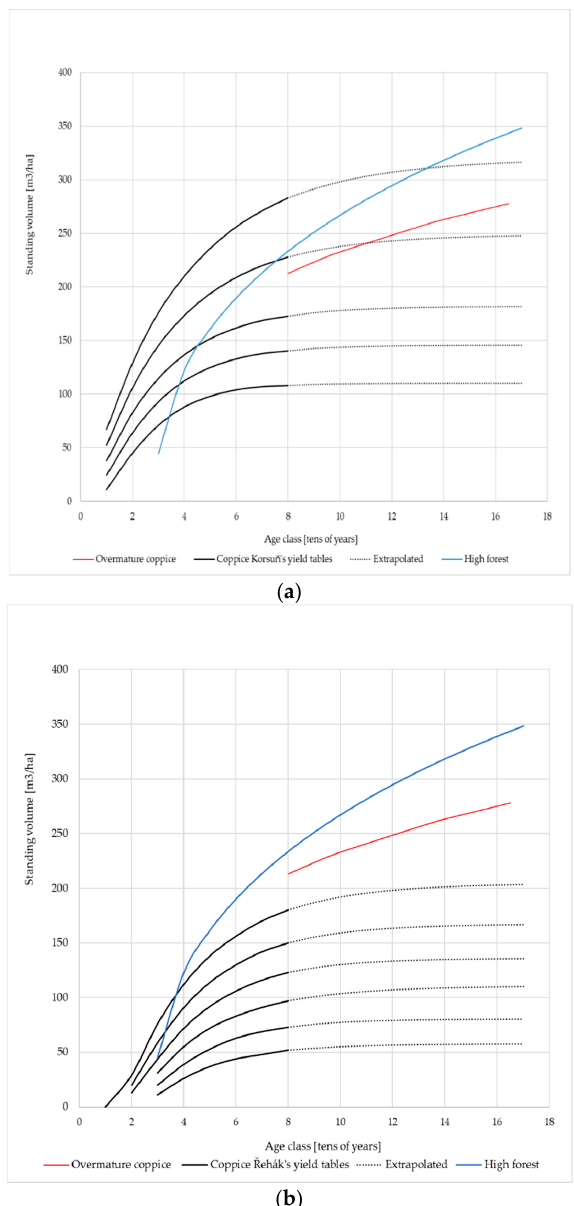
Figure 2. Comparison of site index curves according to Korsu ň ( a ) and Ř ehák ( b ) of real values of actual hectare stock of over ‐ mature oak coppices and high oak forests in LP K ř ivoklátsko.